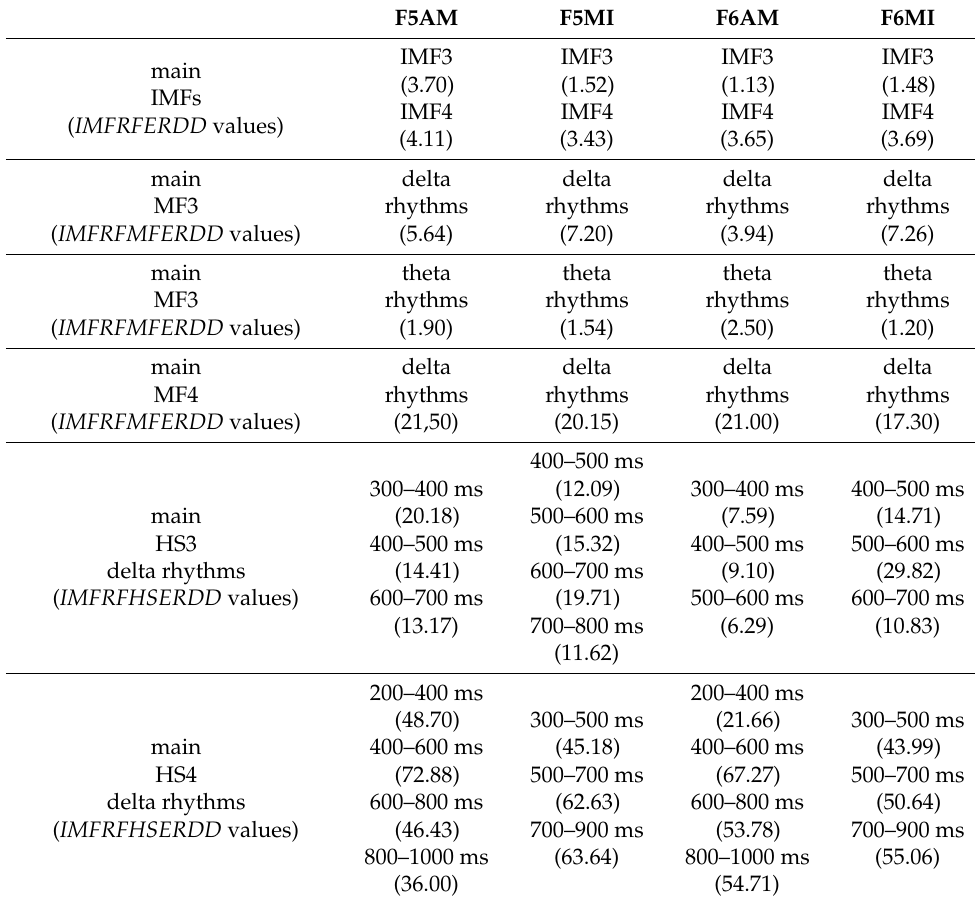
Table 2. IMF-based MF and HS energy feature information for the F5AM, F5MI, F6AM, and F6MI EEG